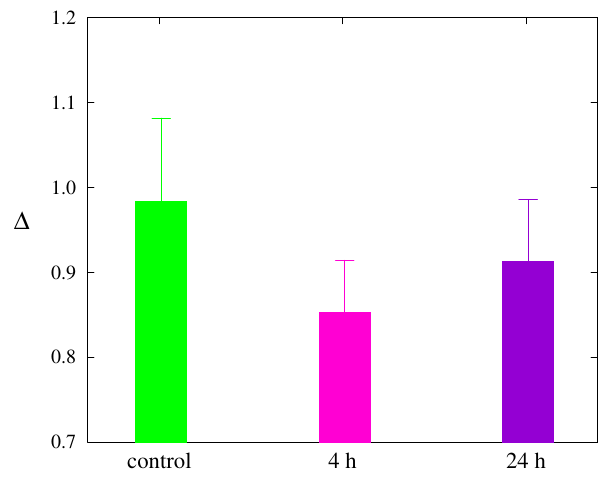
Fig. 8. Statistical analysis of the complexity measure (cid:1) of CVBF-dynamics for three groups of animals (mean (cid:1)